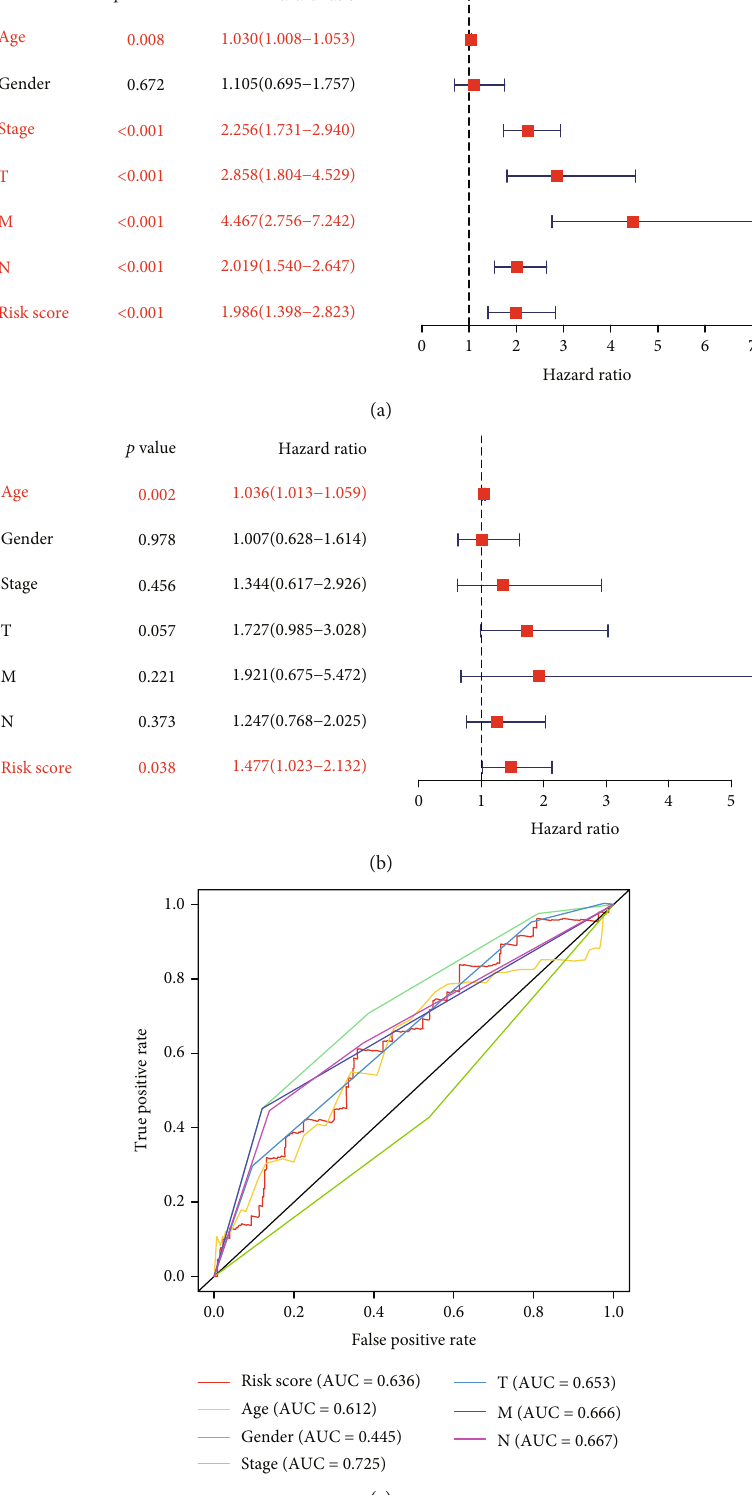
Figure 3: Forest plot visualizing hazard ratios of signi fi cantly survival-related clinical pathological parameters including age, gender, cancer stage, pathological stage T, M, and N, and risk score by performing (a) univariate and (b) multivariate survival analyses; and (c) an ROC plot was used to evaluate the ARP risk model regarding these di ff erent clinical pathological